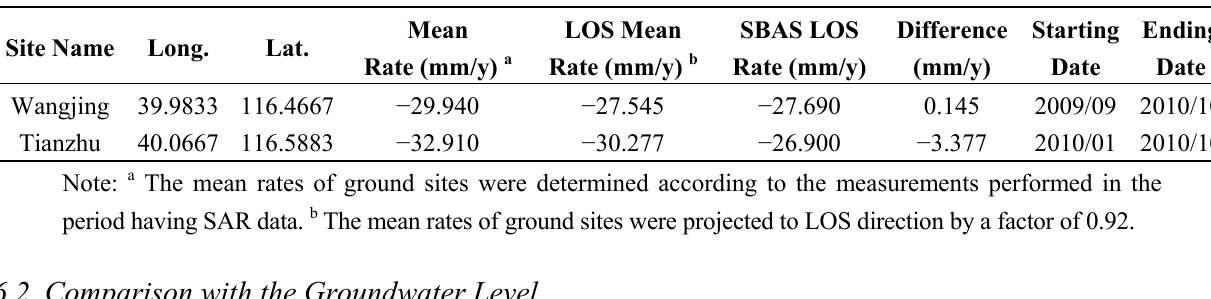
Table 1. Comparison between leveling and SBAS